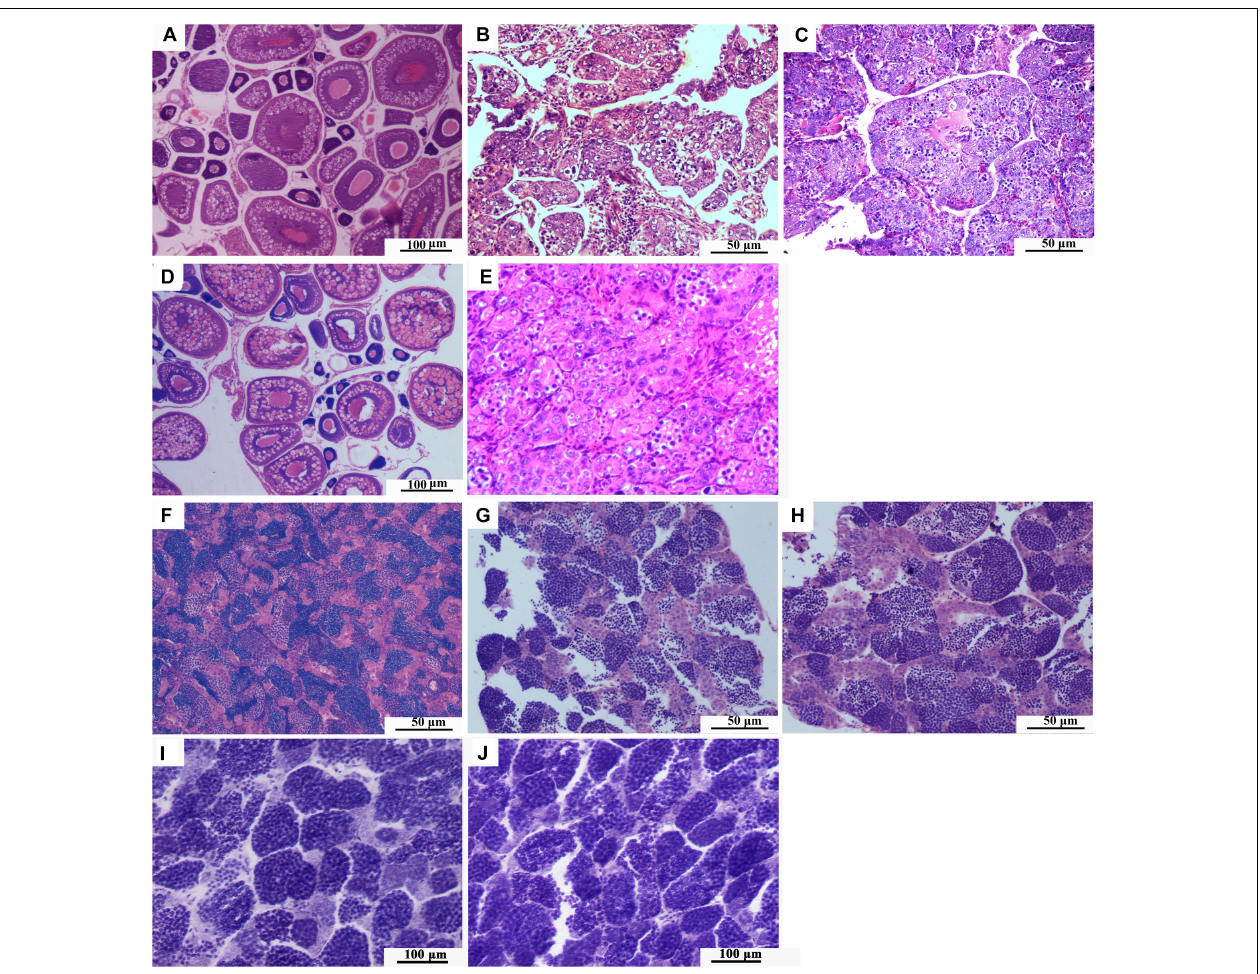
FIGURE 4 | Gonadal development. (A) Histological section of ovary of 1-year-old RCC. (B) Histological section of ovary of 1-year-old 3nALT. (C) Histological section of ovary of 1-year-old 3nAUT. (D) Histological section of ovary of 2-year-old 3nAUT. (E) Histological section of ovary of 2-year-old 3nALT. (F) Histological section of testis of 1-year-old RCC. (G) Histological section of testis of 1-year-old 3nAUT. (H) Histological section of testis of 1-year-old 3nALT. (I) Histological section of testis of 2-year-old 3nAUT. (J) Histological section of testis of 2-year-old 3nALT.